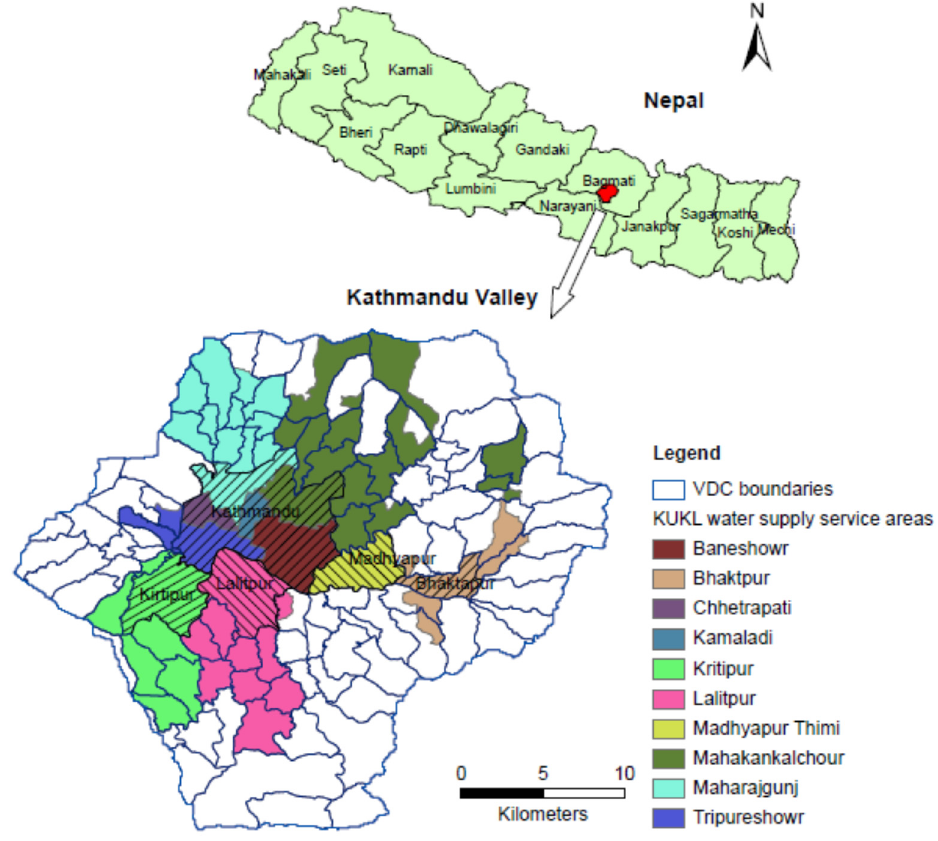
Figure 1. Location of the Kathmandu Valley. Five metropolitan areas are shown with hatches.